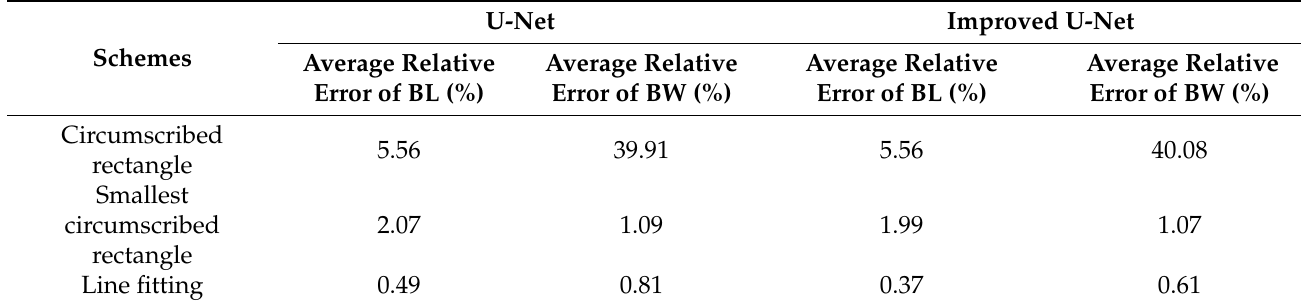
Table 4. Average relative errors of various